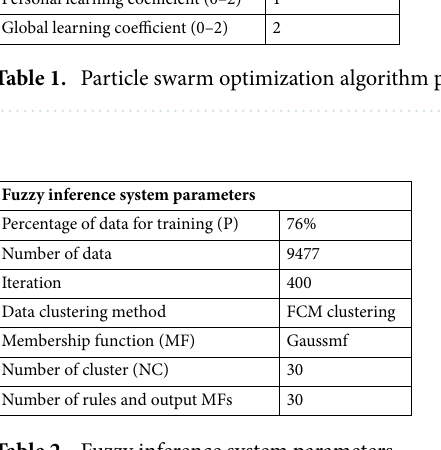
Table 2. Fuzzy inference system